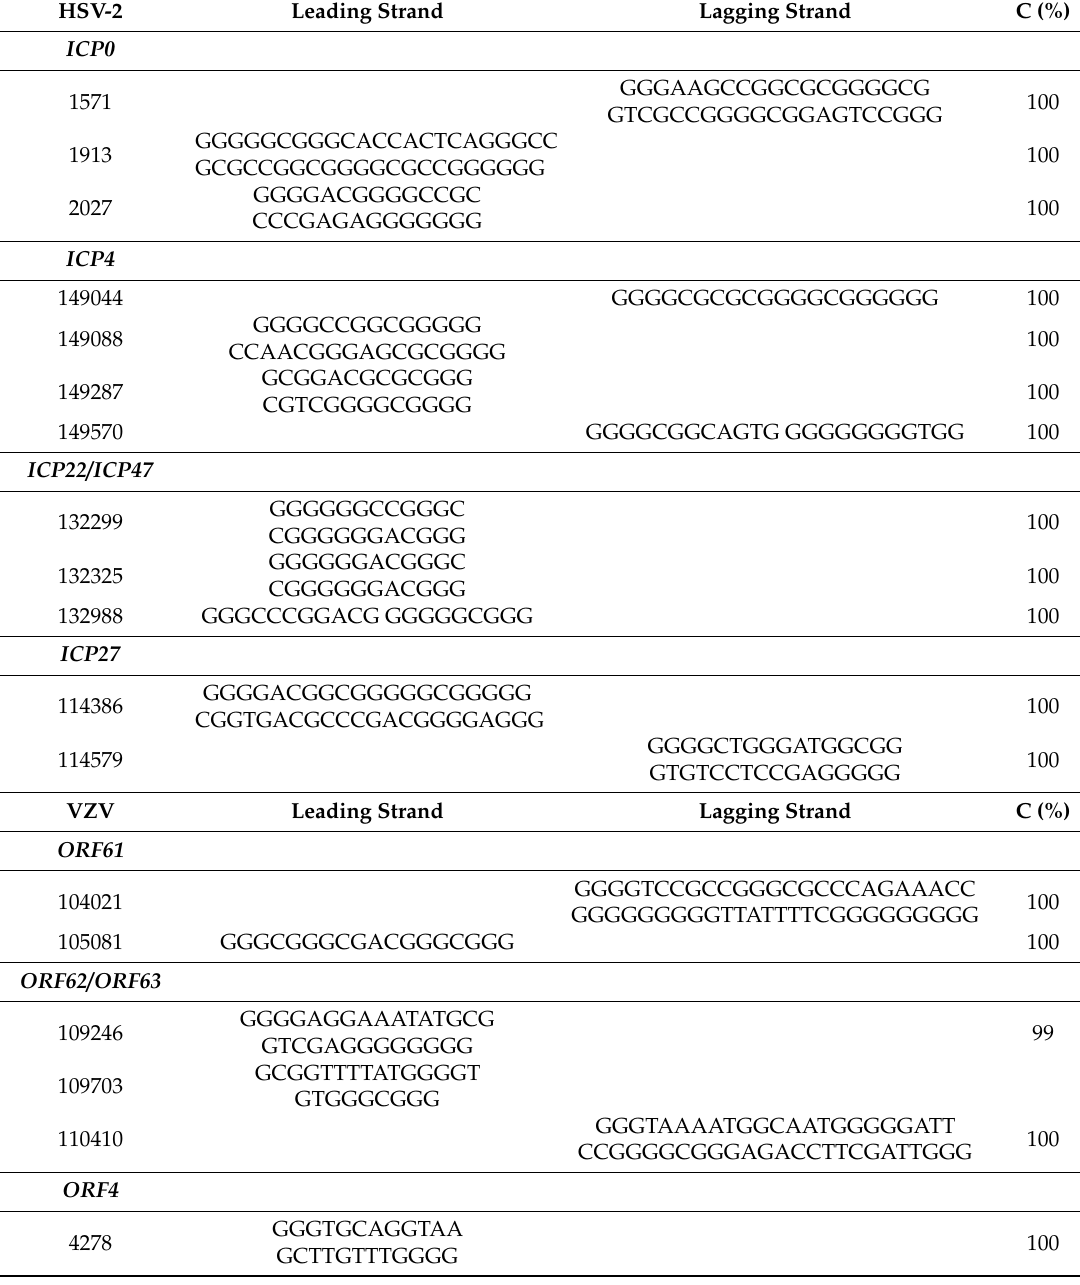
Table 3. PQS in the HSV-2 and VZV IE promoter sequences. Each PQS is indicated by the 5 (cid:48) nt position on the viral reference genome (NC_001798.2 and NC_001348.1). The leading and the lagging strands are indicated with respect to the TSS position. The conservation ratio (C (%)) of the entire sequence (G tracts and loops) among all the strains available in the NCBI databank is also indicated. HSV-2 Leading Strand Lagging Strand C